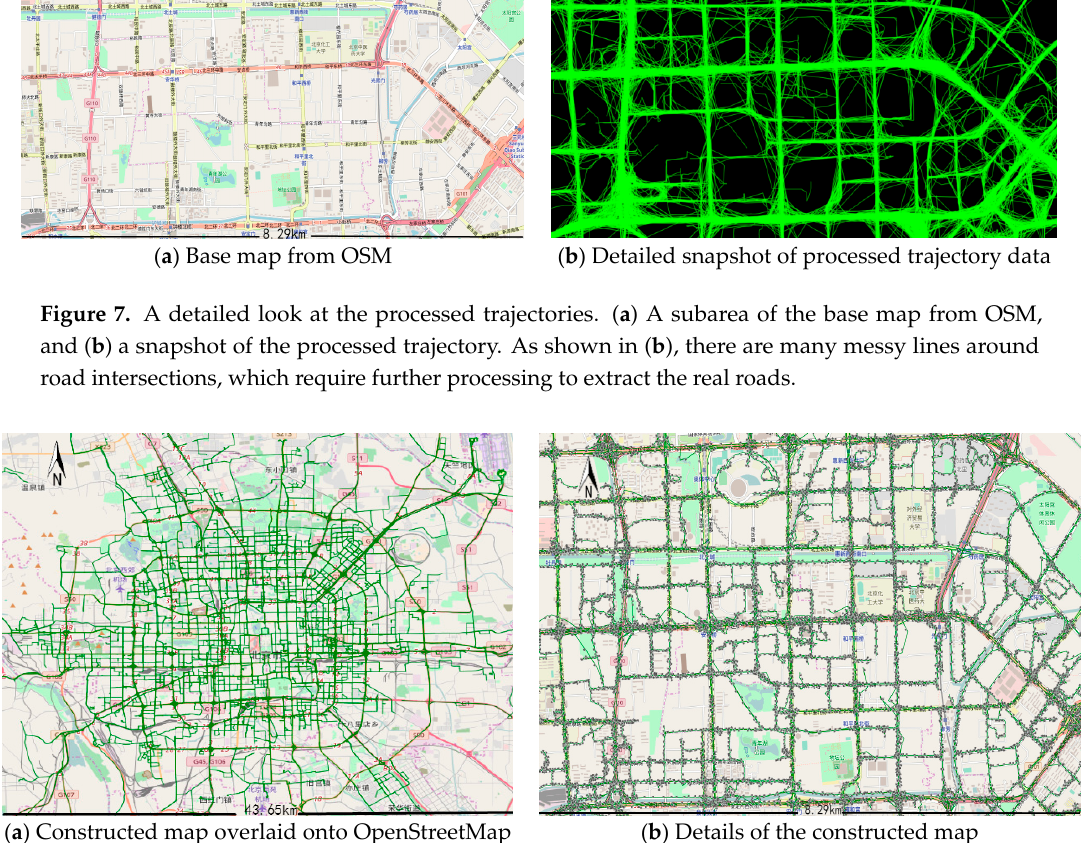
Figure 8. Comparison of the constructed road network with the ground truth. The result is overlaid onto OpenStreetMap, which shows that the resulting map matches the base map very well. ( a ) The overall scenario; the constructed road network is represented as a green graph. ( b ) One subset area of the constructed road network in detail; the directions of the roads are expressed using black arrows.